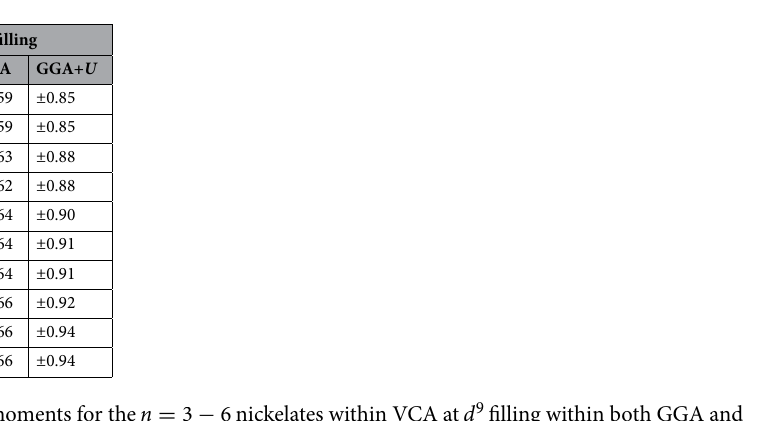
Table 2. Ni magnetic moments for the n GGA+ U . Here, i , m , and o denote the inner-, mid-, and outer-Ni atoms, respectively.